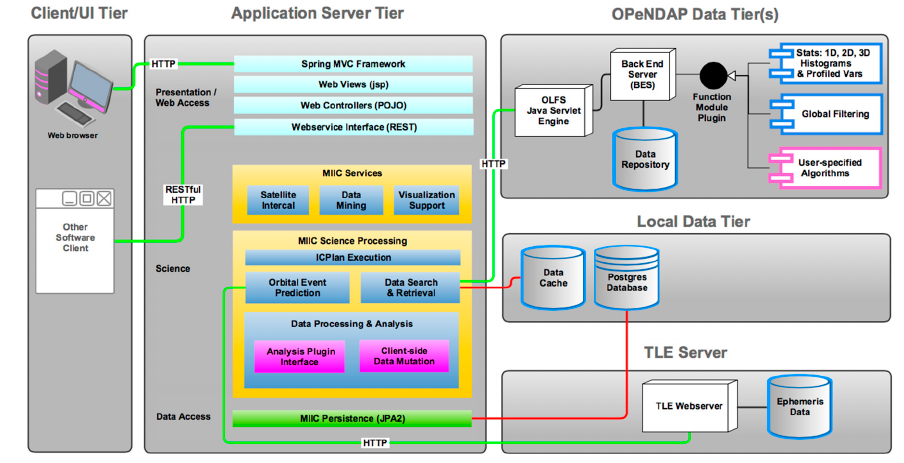
Figure 2. MIIC data system architecture.